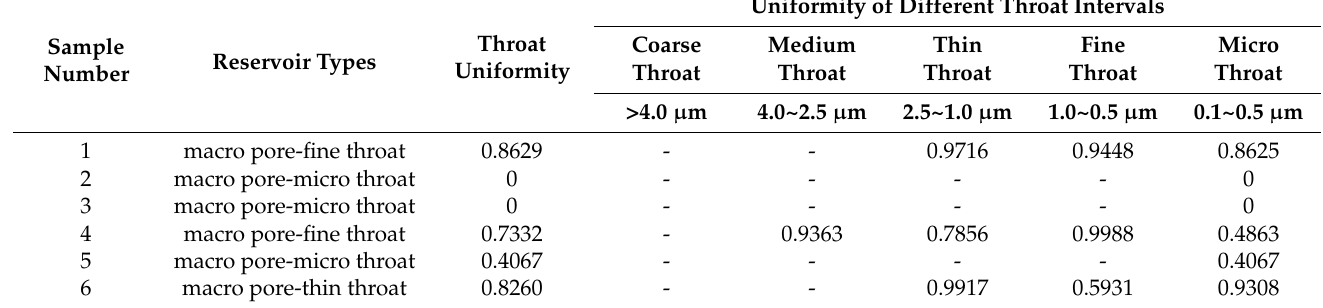
Table 3. Quantitative characterization of throat radius heterogeneity in different pore-throat combi- nation